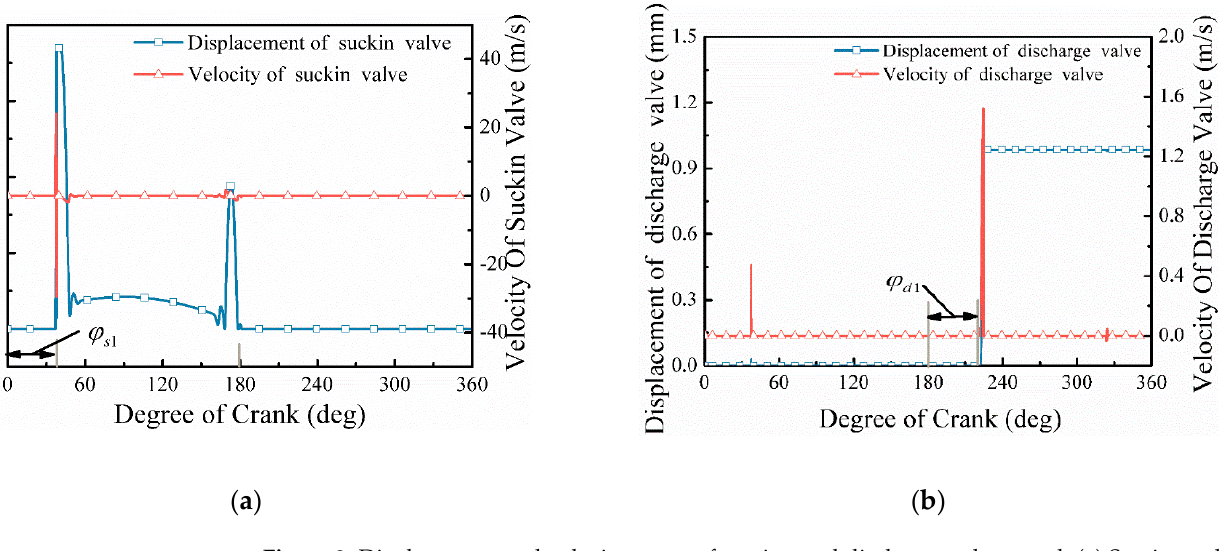
Figure 9. Displacement and velocity curve of suction and discharge valve spool. ( a ) Suction valve spool displacement velocity curve. ( b ) Discharge valve spool displacement velocity curve.